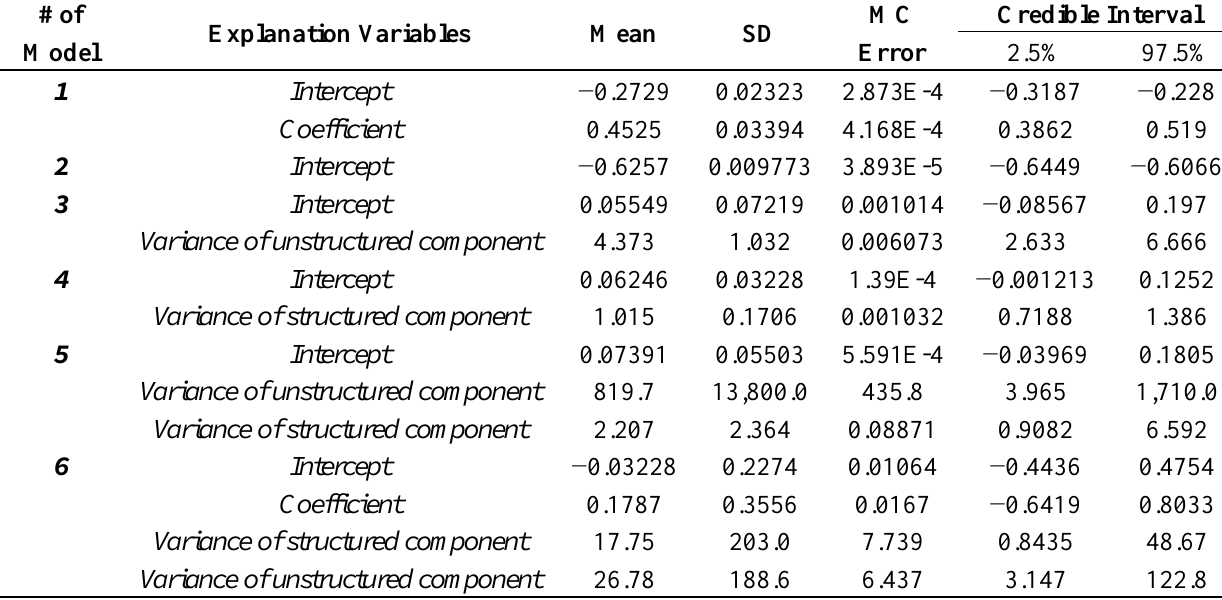
Table 4. A posterior summary of the results of hierarchical Bayesian models from